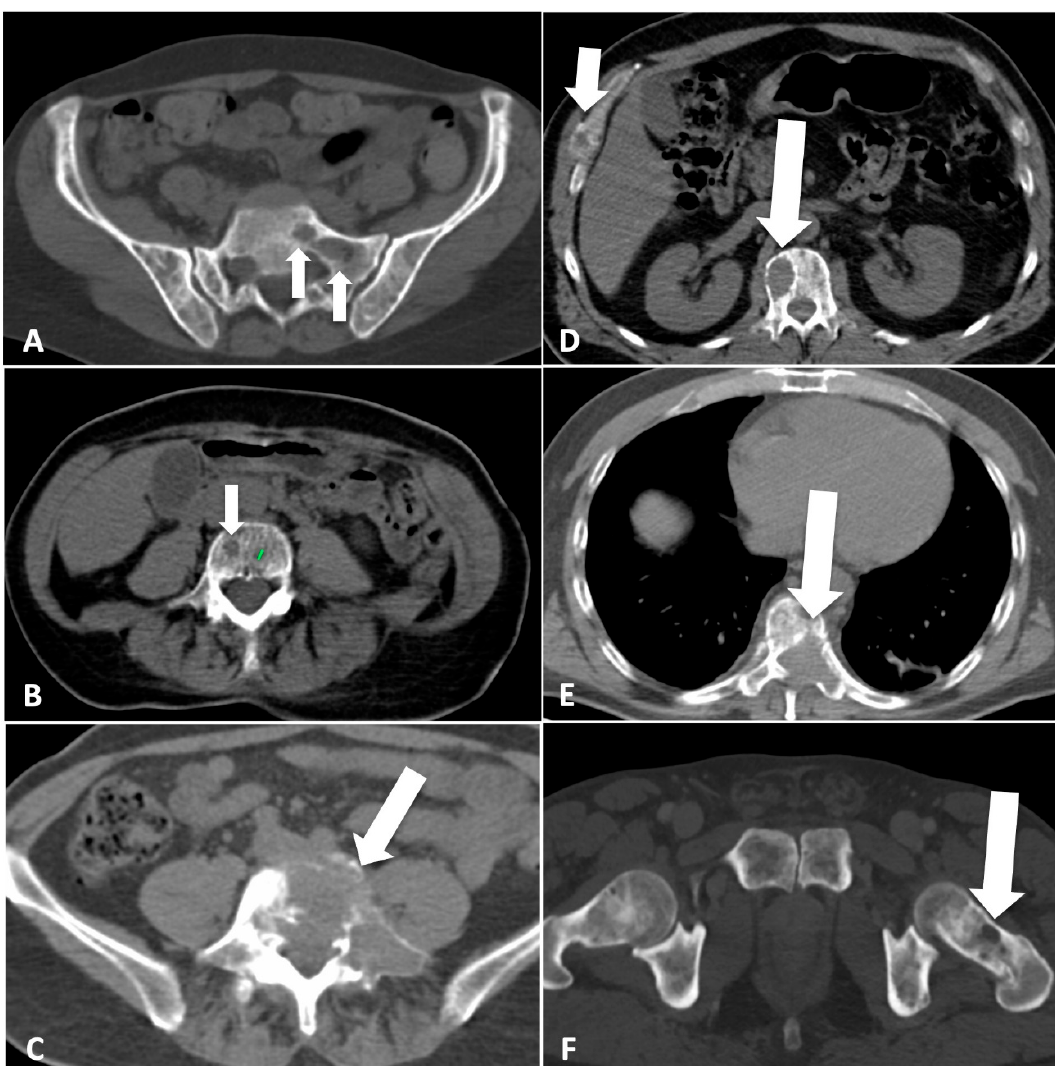
Figure 1. Scoring bone damage and instability: spectrum of findings. ( A ) Focal lytic lesions >5 mm in diameter located at the left sacrum (white arrows). In this case the MSBDS was 2 (1 + 1). ( B ) Single focal lytic lesion >5 mm in the vertebral body (white arrow) with no vertebral collapse (sagittal not shown). The adjacent smaller focal lytic lesion (green line) is <5 mm (no points in the MSBDS). In this case, the MSBDS was 1. ( C ) Large lytic lesion at the junctional spine (L5-S1) with cortical erosion, collapse/involvement >50%, posterolateral (facet, pedicle) involvement and more than 2/3 of bone diameter. In this case, the MSBDS was 11 (3 + 3 + 2 + 3): the lesion was considered “high-risk” and immediate surgical or radiation oncologist consultation was warranted. In this case, there was also possible spinal canal involvement. ( D ) Lytic lesion >5 mm (white arrow) at the junctional spine (thoracic spine) with collapse/involvement <50% and a small (small white arrow) focal lesion at the anterior arch of the right rib cage with extraosseous extension. In this case, the MSBDS was 6 (3 + 2 + 1): the lesion was considered “medium-risk” (5–10 with medium risk of pathologic fracture). ( E ) Large lytic lesion at the junctional spine (thoracic spine) with collapse/involvement >50%, posterolateral (facet, pedicle) involvement and more than 2/3 of bone diameter. In this case, the MSBDS was 11 (3 + 3 + 2 + 3): the lesion was considered “high-risk” and immediate surgical or radiation oncologist consultation was warranted. In this case, there is spinal canal involvement. ( F ) Lytic lesion at the left femoral neck (white arrow). This lesion alone warrants 5 points in the MSBDS: the lesion was considered “medium-risk”, although immediate fracture seems